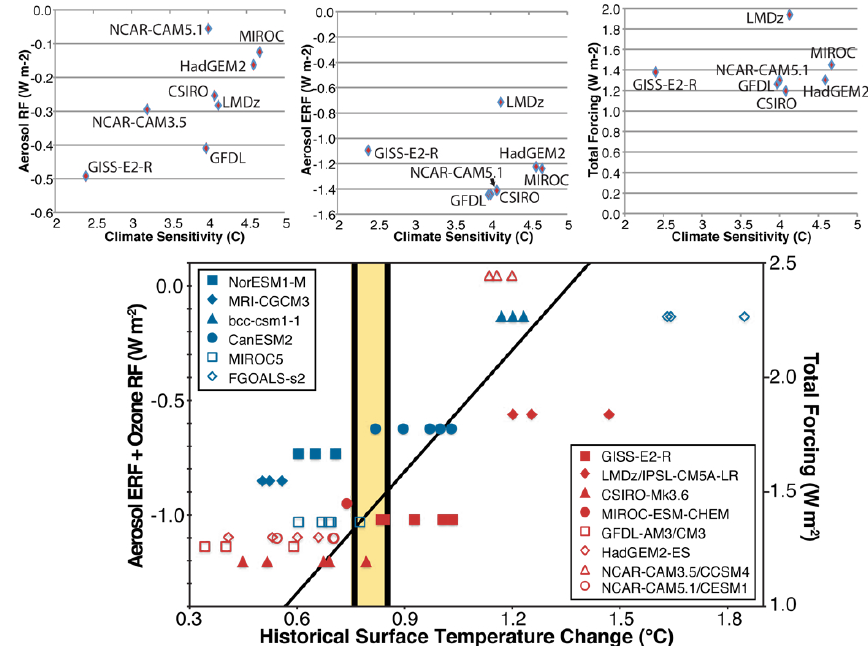
Fig. 22. Relationship between 1850 to 2000 forcings and ECS (top row) or historical warming (bottom panel) in the indicated models. Total forcing includes RF values of 2.30, − 0.17, 0.07 and 0.10Wm − 2 for WMGHGs, land-use, stratospheric water, and solar irradiance, respectively. In the lower panel, temperature changes are differences between 1850–1859 and 1996–2005 from observations (CRU left vertical line, GISS right vertical line) and models. For CMIP5 models (Table G2), the ACCMIP mean ozone forcing of 0.35Wm − 2 is used. Points show temperatures from individual realizations. The black line is the regression through the model